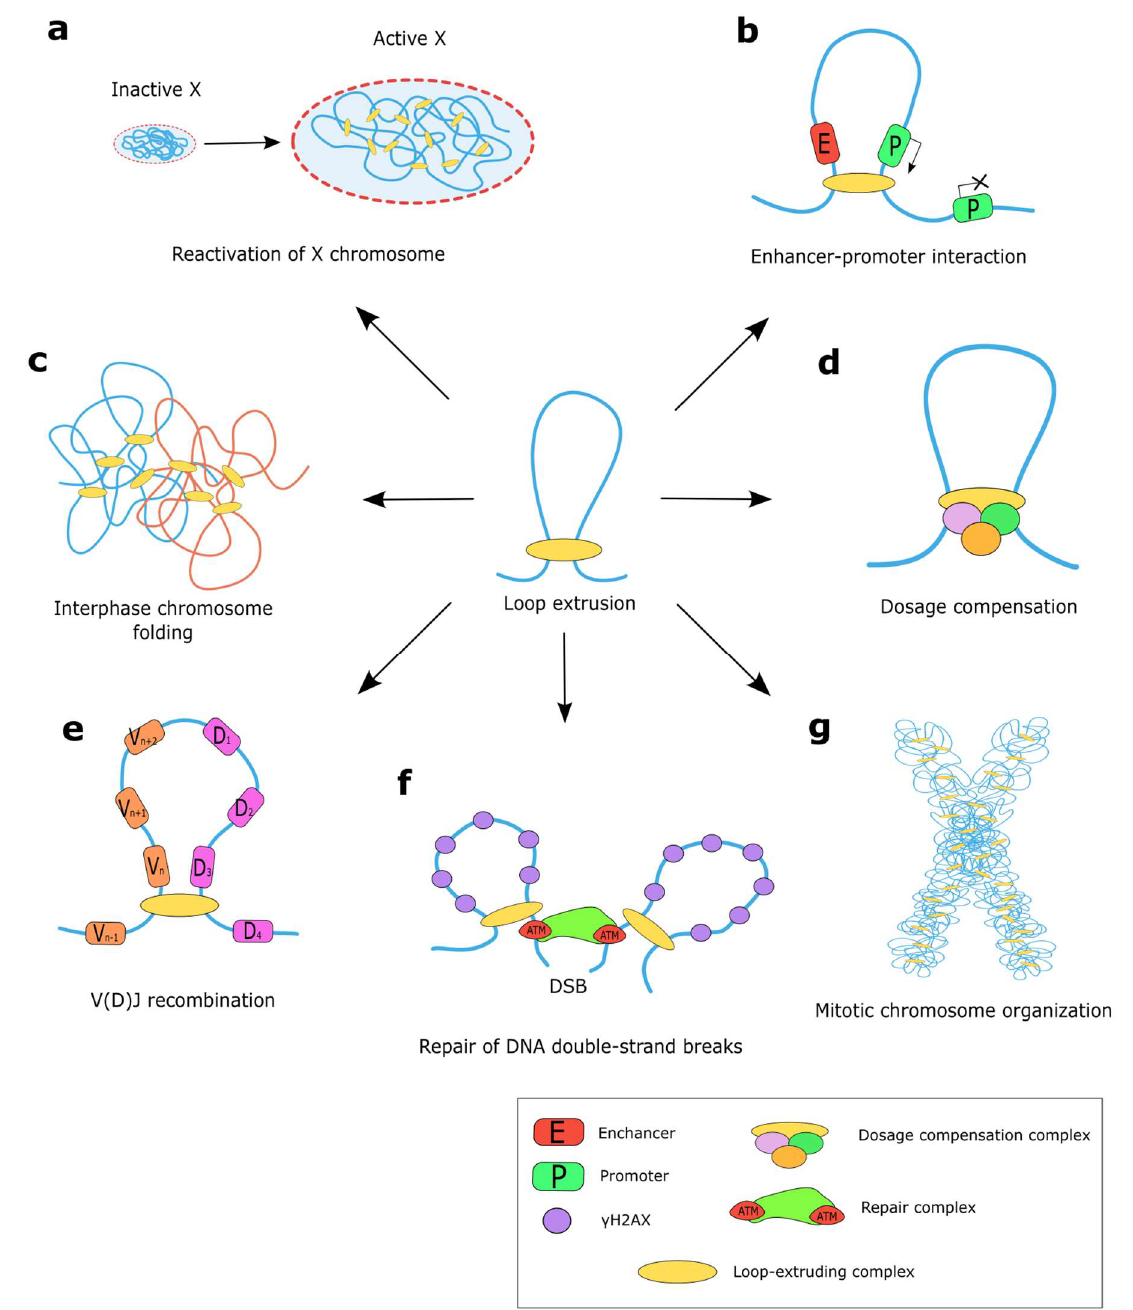
Figure 3. The functions of SMC complex. ( a ) The cohesin complex member SMC1a is hypothesized to provide reactivation of the inactive X chromosome of mice [50] . ( b ) Loop extrusion can prevent enhancer–promoter interactions by isolating them from one another or can facilitate enhancer–promoter interactions by converging them. ( c ) Formation of loops by cohesin is essential for establishing chromosome territories and suppressing interchromosome entanglements in vertebrate cells. ( d ) Loop extrusion by specialized condensin complex participates in dosage compensation of C. elegans [32] . ( e ) Loop extrusion activity mediates bringing DNA segments together during V(D)J recombination. ( f ) Cohesin-mediated loop extrusion on both sides of the double-strand breaks allows ATM to phosphorylate H2AX containing nucleosomes signaling for the repair system [51] . ( g ) Condensin complexes are a crucial factor determining compaction of chromosomes during mitosis [52] .